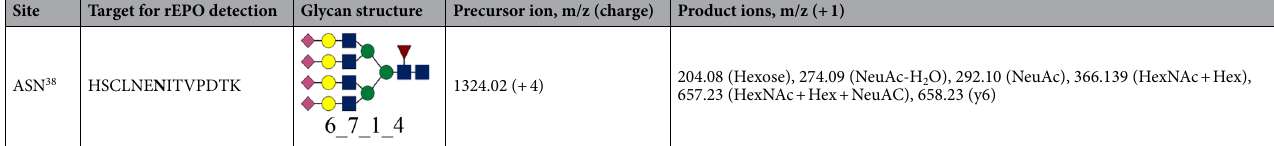
Table 2. Transition used for the target analysis.